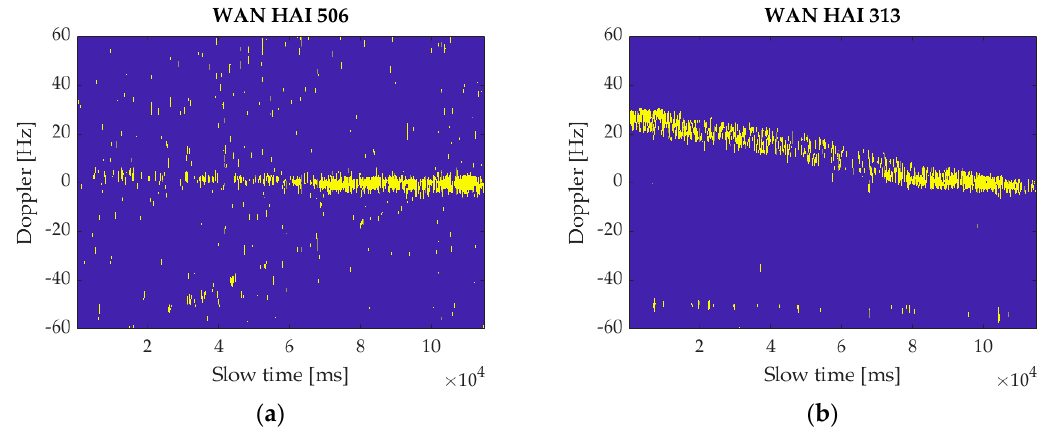
Figure 9. Two binary images for two cargo ships: ( a ) is WAN HAI 506, and ( b ) is WAN HAI 313.